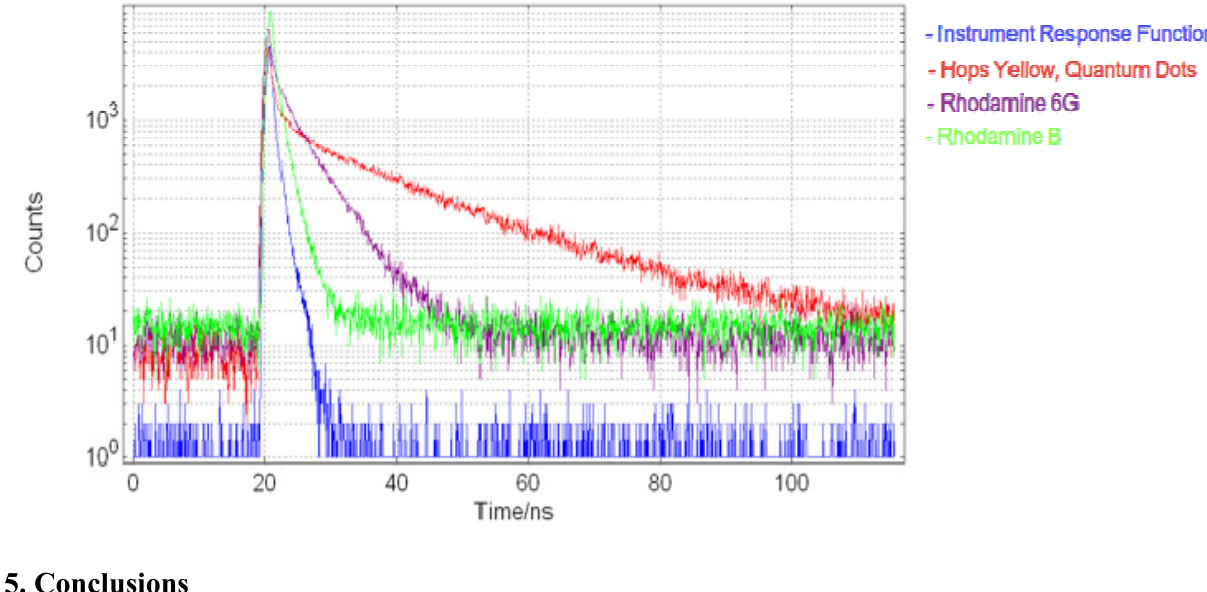
Figure 15. Fluorescence decay curves measured using two-chip micro-system, of quantum dot, Rhodamine 6G and Rhodamine B samples. An IRF of 910 ps FWHM is also included